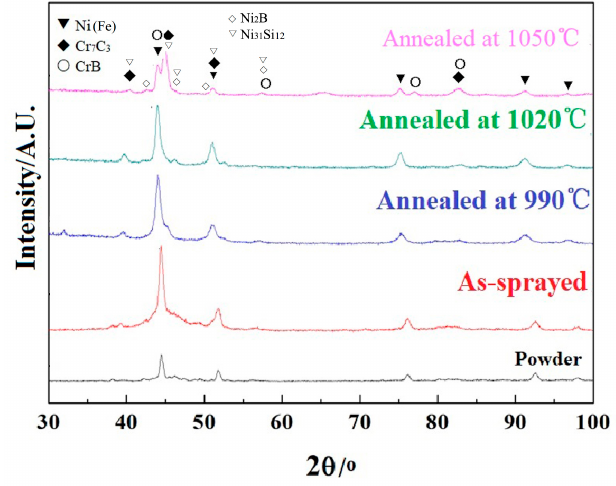
Figure 9. XRD analysis of the powder and coatings.